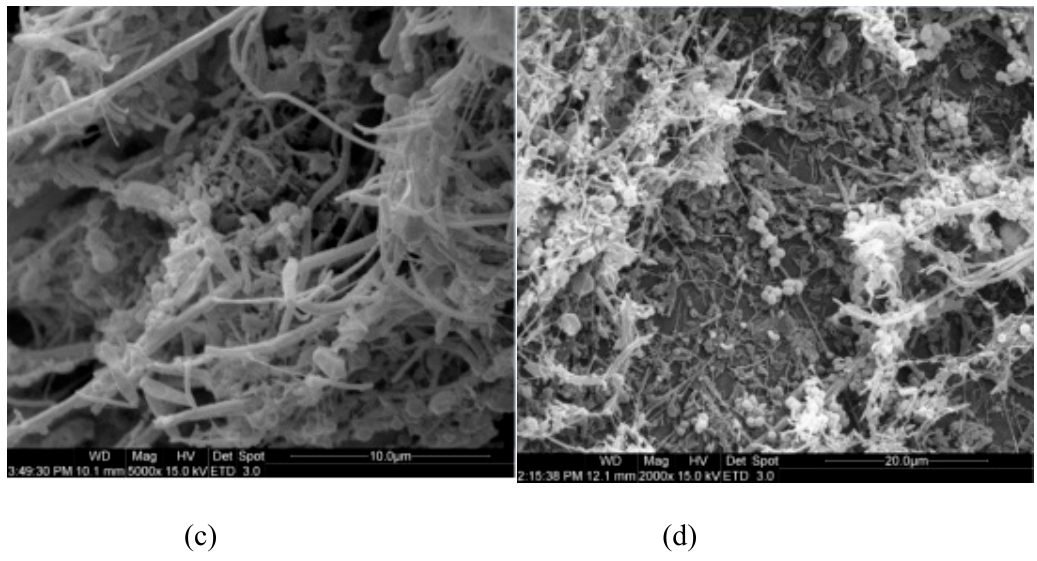
Figure 3. SEM micrographs of the biofilm at di ff erent FRs: ( a ) 20%, ( b ) 30%, ( c ) 40% and ( d ) 50%.